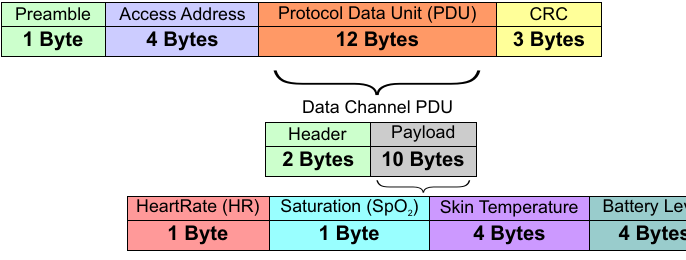
Figure 3. BLE data packet